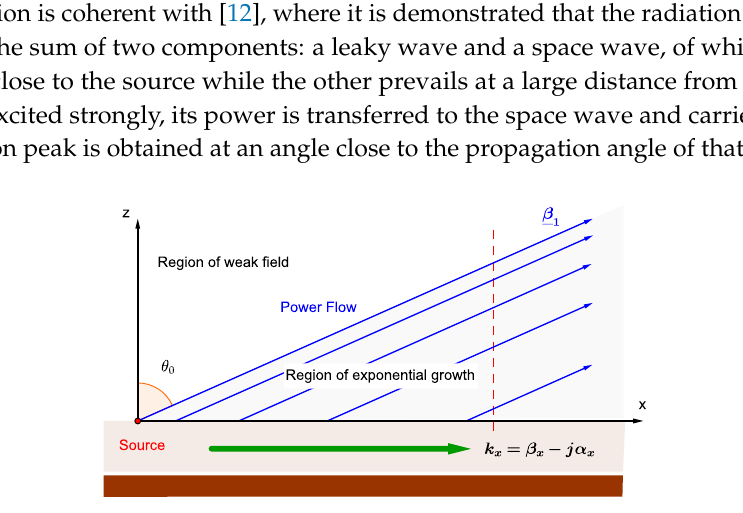
Figure 4. Ray pictures for the physical interpretation of an improper leaky-wave